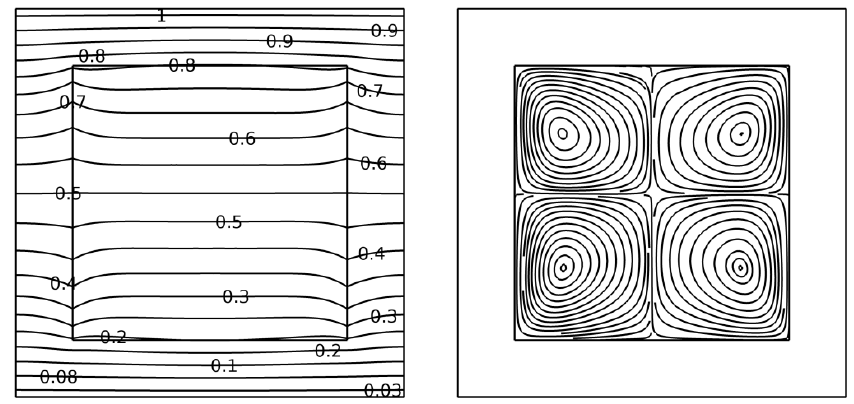
Figure 14. Streamlines and isothermals obtained when heating the top, W max = 2.6317.